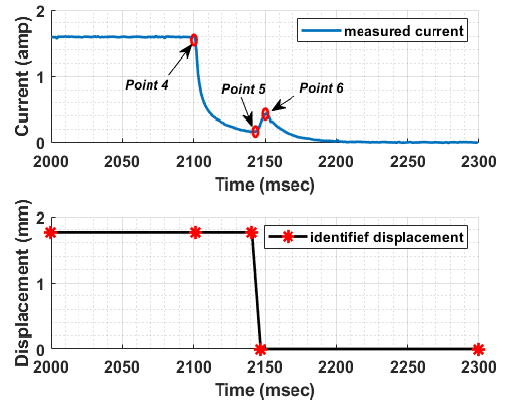
Figure 16 Current analysis when the solenoid is de- energized and the corresponding indicated displacement.